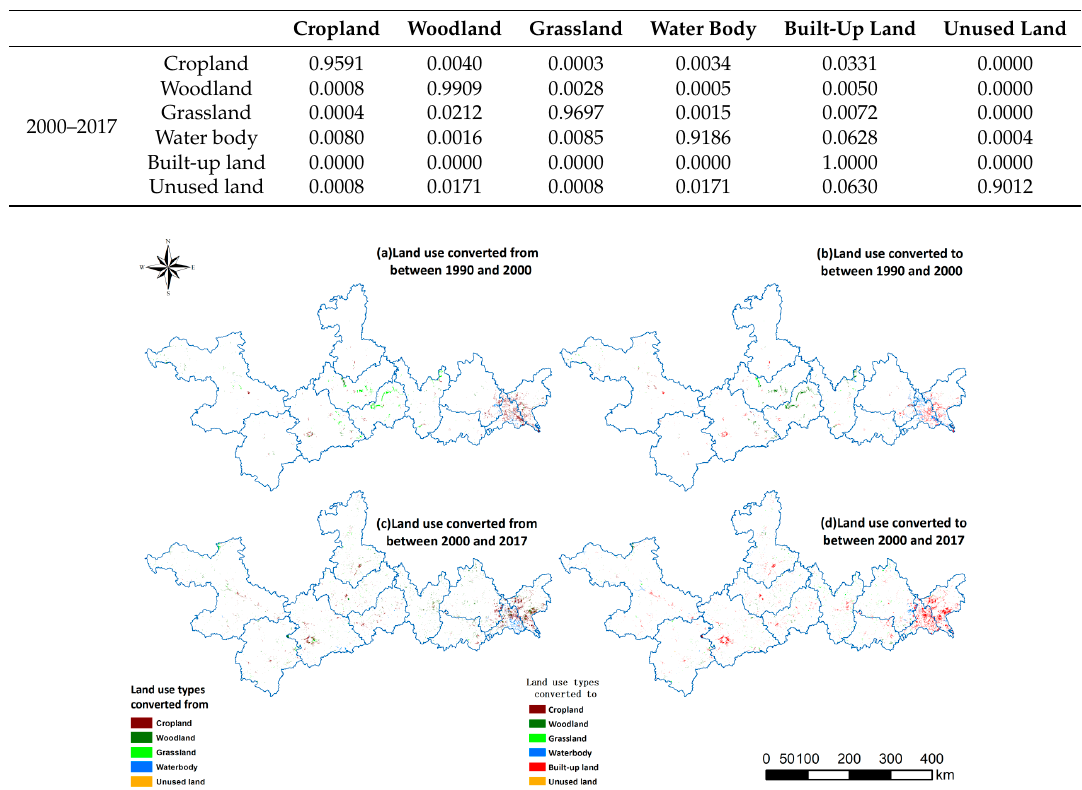
Figure 5. The spatial pattern of land-use and land-cover change (LUCC) in the